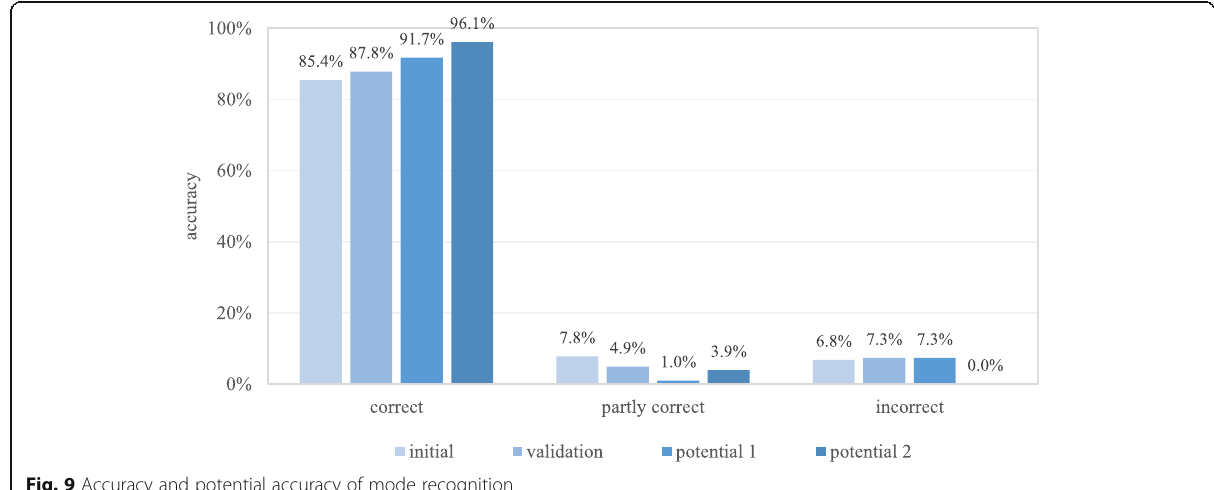
Fig. 9 Accuracy and potential accuracy of mode